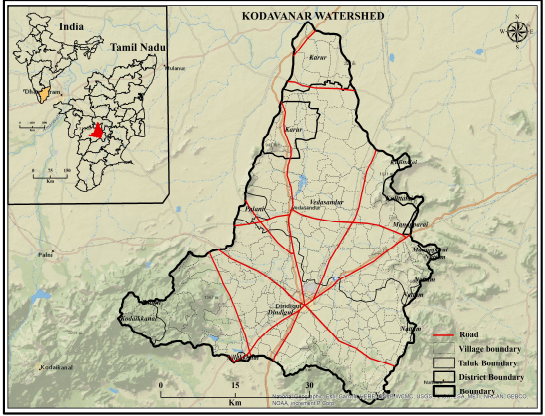
Figure 1: Location of Kodavanar watershed, Tamil Nadu-India